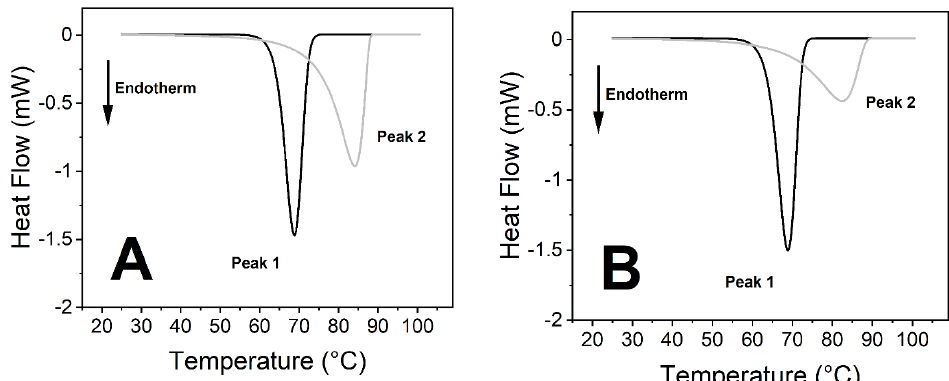
Figure 4. Deconvolution of peak 1 and peak 2 from Figure 3 DSC plots. ( A ) Control: 50 h of incubation at 37 °C. ( B ) Treated with SARS-CoV-2 and incubated for 50 h at 37 °C.